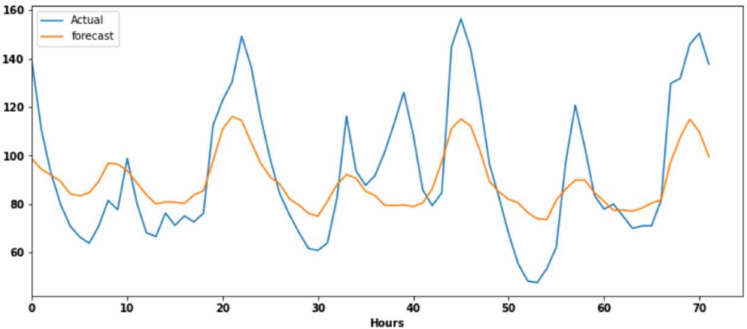
Figure 19. Forecasting for the next 72 h for Islamabad using the multivariate FbProphet model.